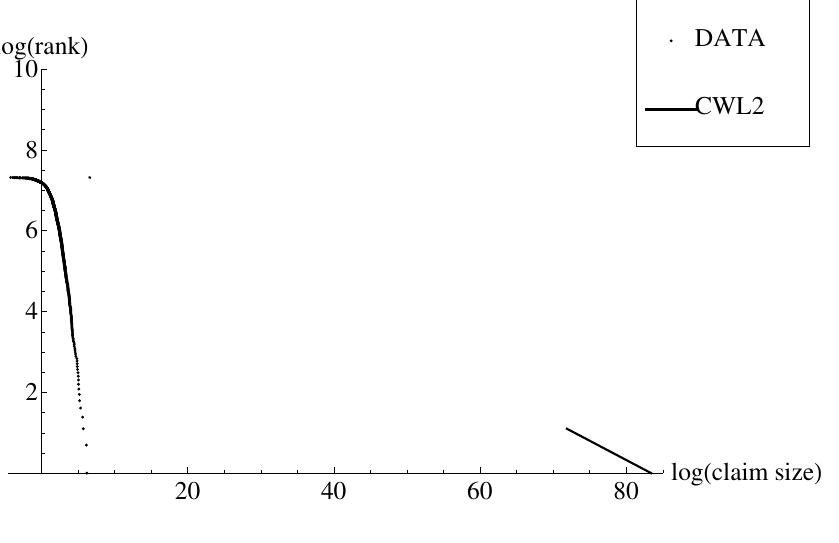
Figure 2. Relationship between claim rank and claim size in log–log scale and graphs of the inverse of the survival function of composite Weibull–Pareto model in Bakar et al. (2015) (CWL2,